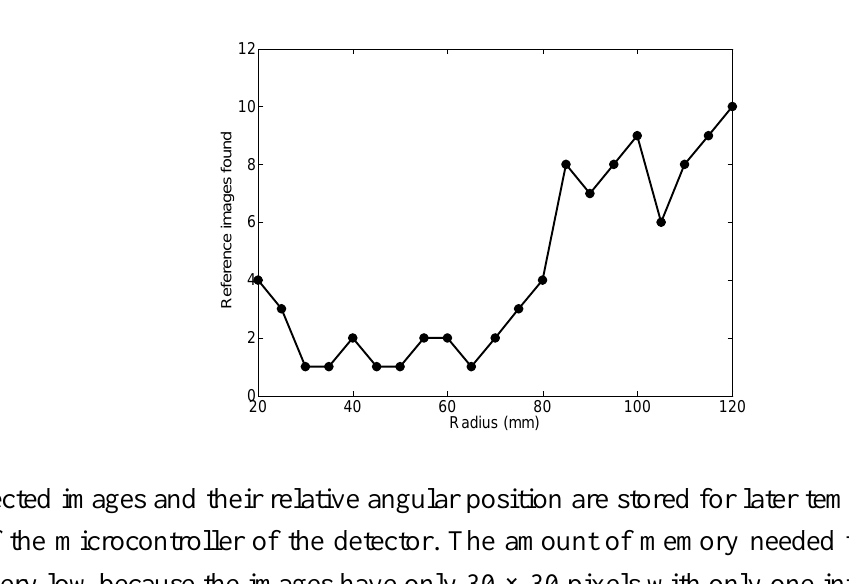
Figure 13. Number of reference images automatically selected depending on the placement radius of the optical